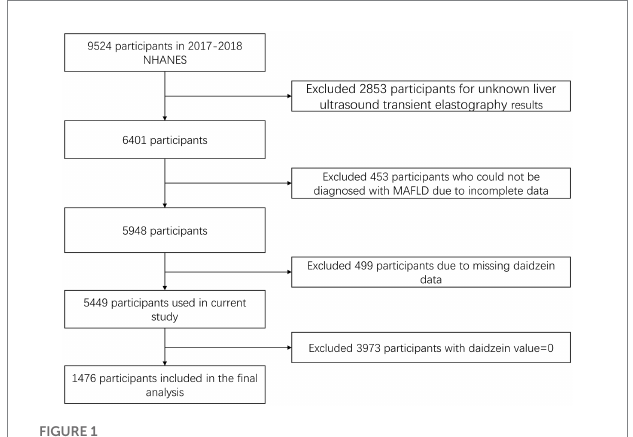
FIGURE 1 Flowchart of the selection process of the participants in NHANES 2017–2018. NHANES, National Health and Nutrition Examination Survey; MAFLD, metabolic associated fatty liver